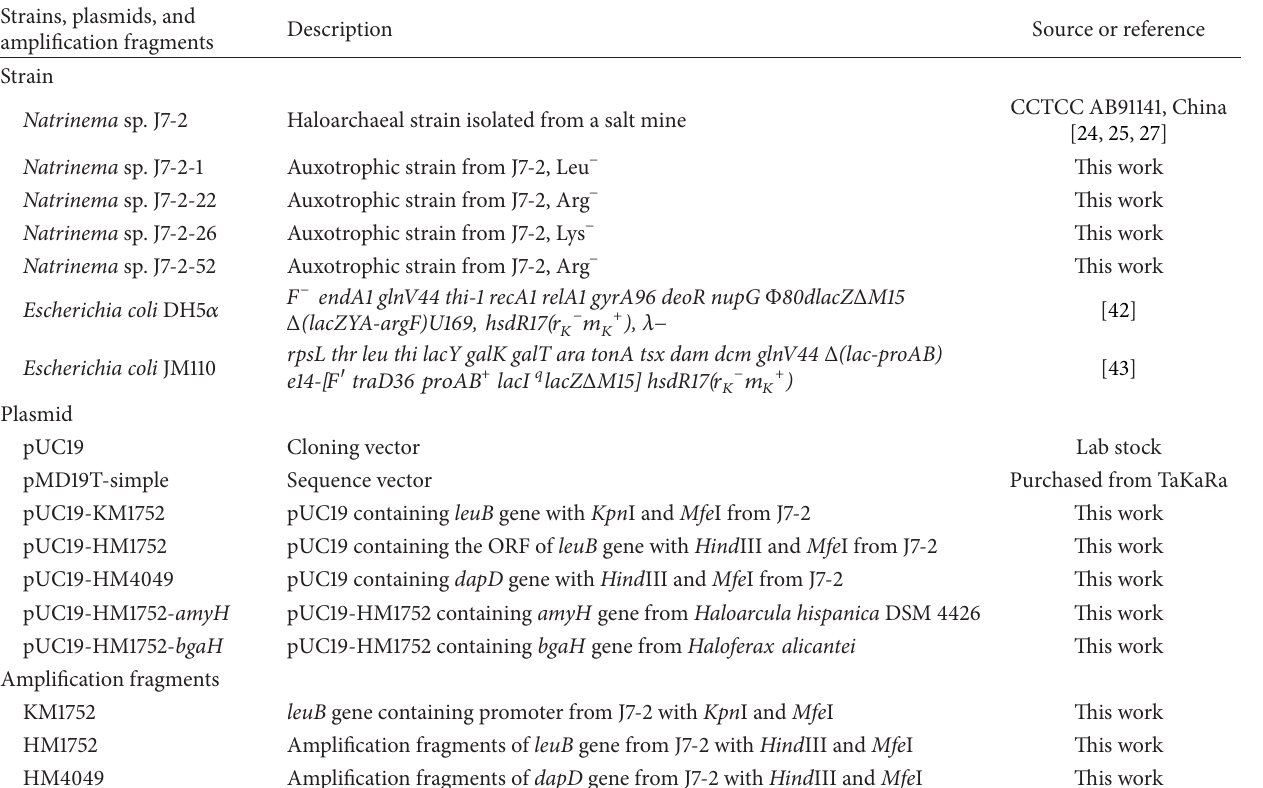
Table 1: Strains, plasmids, and amplification fragments used in this